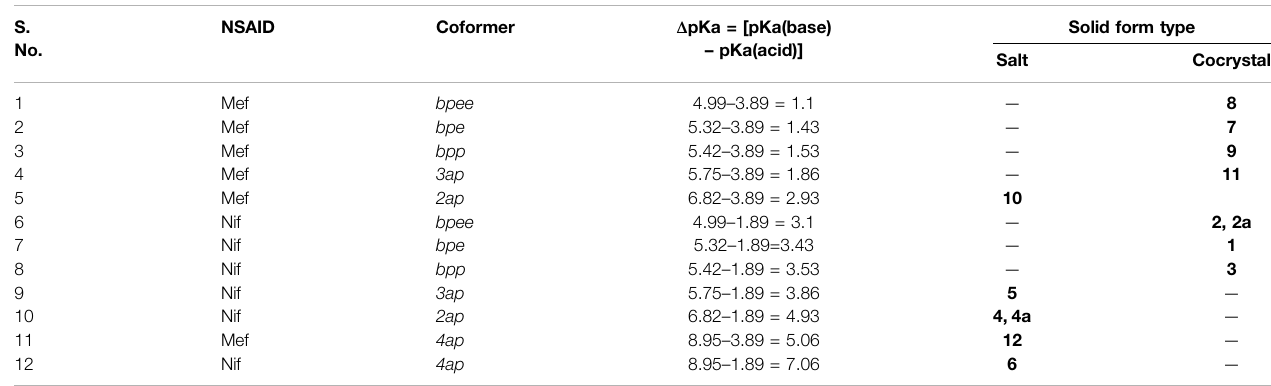
TABLE 3 | The outcome of solids by p K a difference between Nif, Mef, and coformers. S. No.